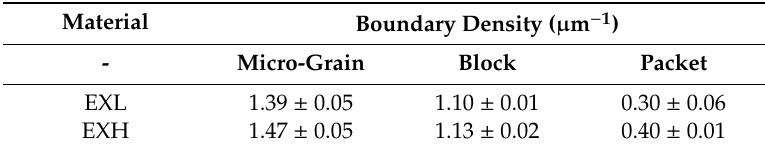
Table 4. Comparison of boundary length per unit area of prior-austenite grain constituents between EXL and EXH.